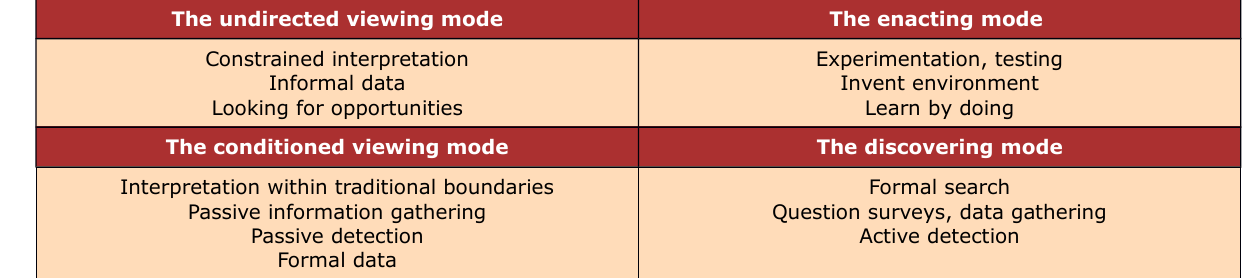
Table 1. The interpretation modes of organization (Daft & Weick,